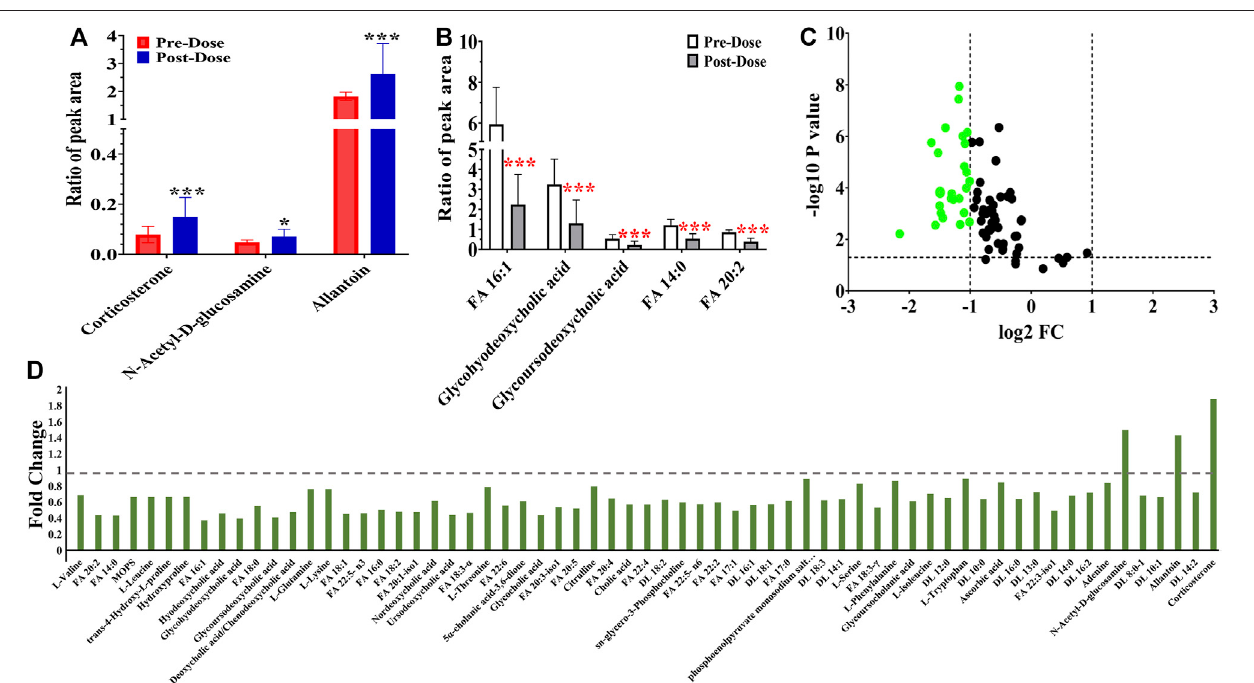
FIGURE 4 | Metabolic peak area ratio comparison between the pre- and post-dose. (A) Upregulated metabolites compared with the pre-dose group. (B) Most signi fi cantdownregulatedmetabolitescomparedwiththepre-dosegroup. (C) VolcanomapofmetaboliteswithVIP > 1, p < 0.05,greendotsrepresentmetabolitesofFC < 0.5. (D) Fold change landscape of all signi fi cant disturbance metabolites. * p < 0.05 and *** p < 0.001, two-tailed unpaired t -test.